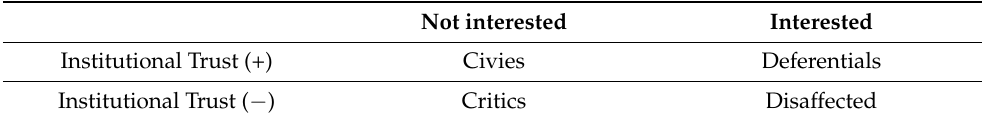
Table 1. Citizen